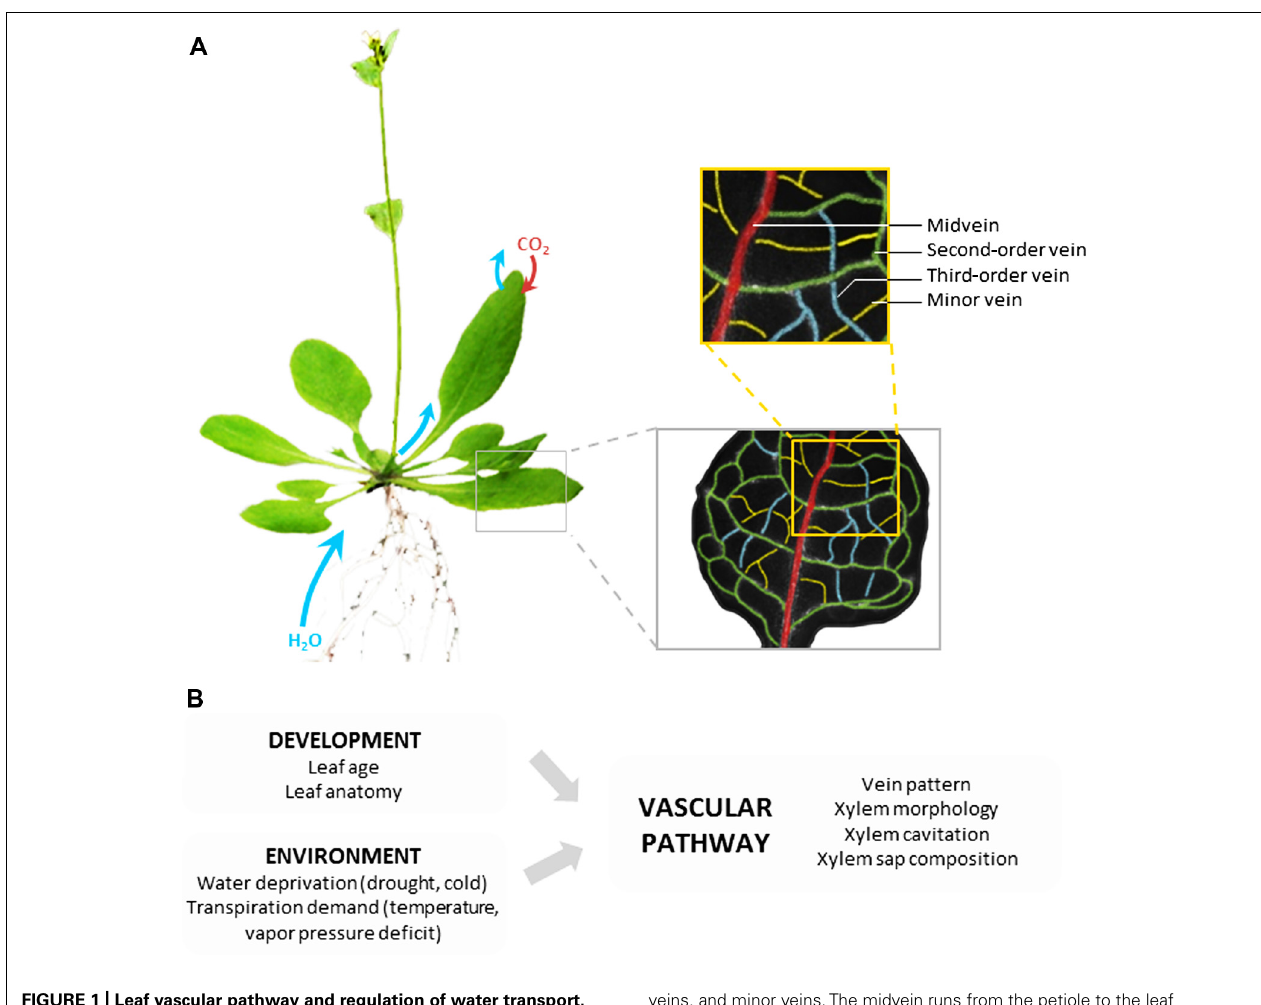
FIGURE 1 | Leaf vascular pathway and regulation of water transport. (A) Based on the example of Arabidopsis thaliana , the figure shows that following uptake by roots and transfer to shoots, water is delivered throughout the whole leaf lamina by a highly organized network of veins. The non-living vessels form the leaf vascular pathway which is constructed according to a hierarchical order with midvein, second-order veins, third-order